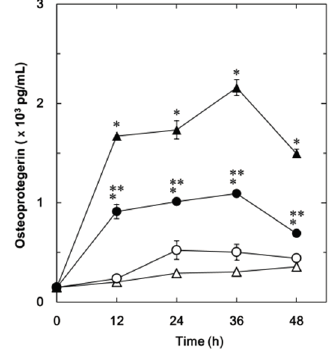
Figure 1. The effect of resveratrol on the FGF-2-stimulated osteoprotegerin release in MC3T3-E1 cells. The cultured cells were pretreated with 50  M of resveratrol ( ● , ○ ) or vehicle ( ▲ , △ ) for 60 min and then stimulated by 30 ng/mL of FGF-2 ( ● , ▲ ) or vehicle ( ○ , △ ) for the indicated periods. Osteoprotegerin concentrations of the culture medium were determined by enzyme-linked immunosorbent assay (ELISA). Each value represents the mean ± SEM of triplicate determinations from three independent cell preparations.  p < 0.05, compared to the value of control. ** p < 0.05, compared to the value of FGF-2 alone.